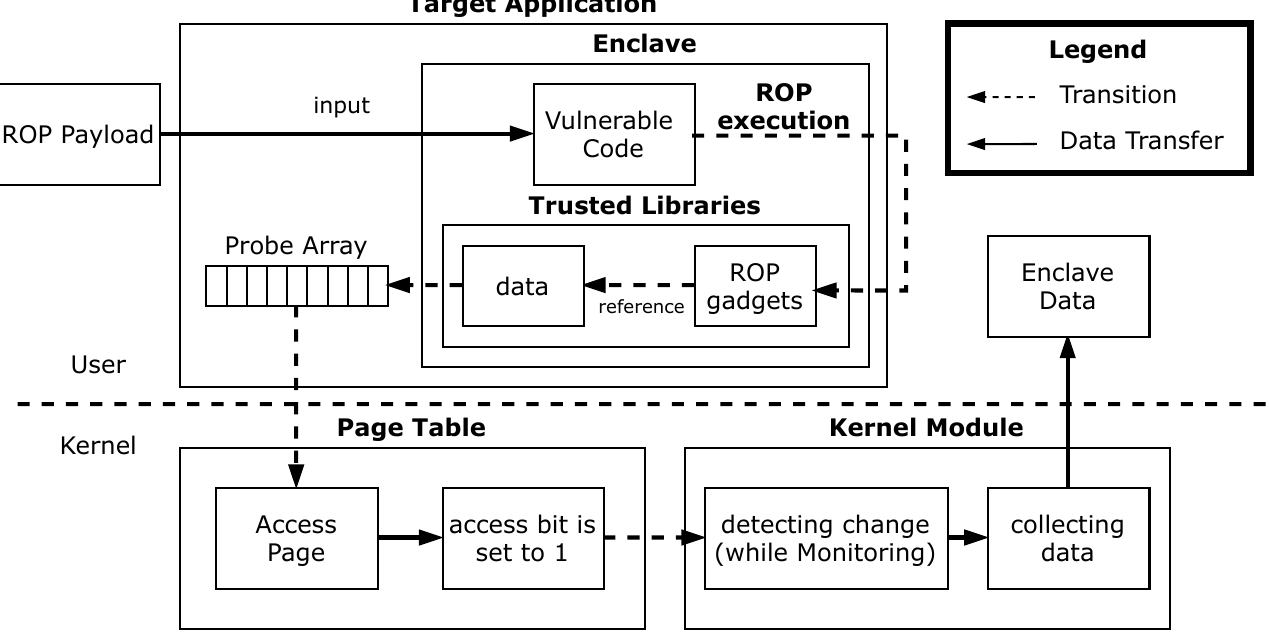
Figure 2. The proposed SGXDump